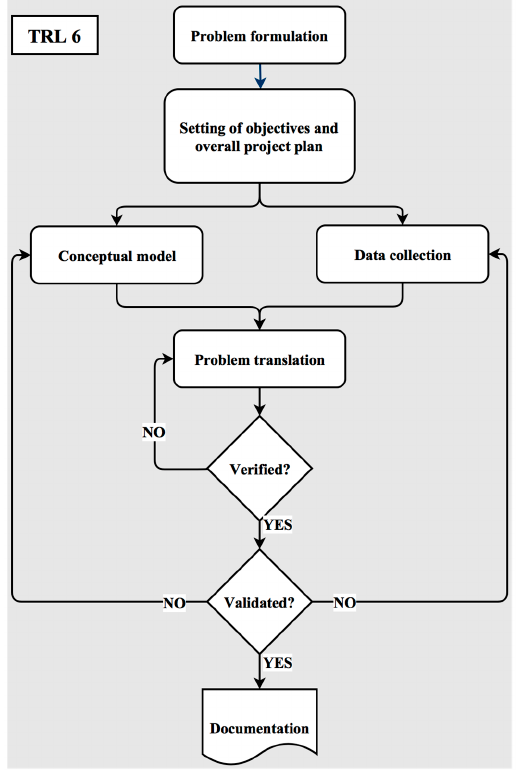
Figure 2. Steps in a simulation study (reproduced after [11]).